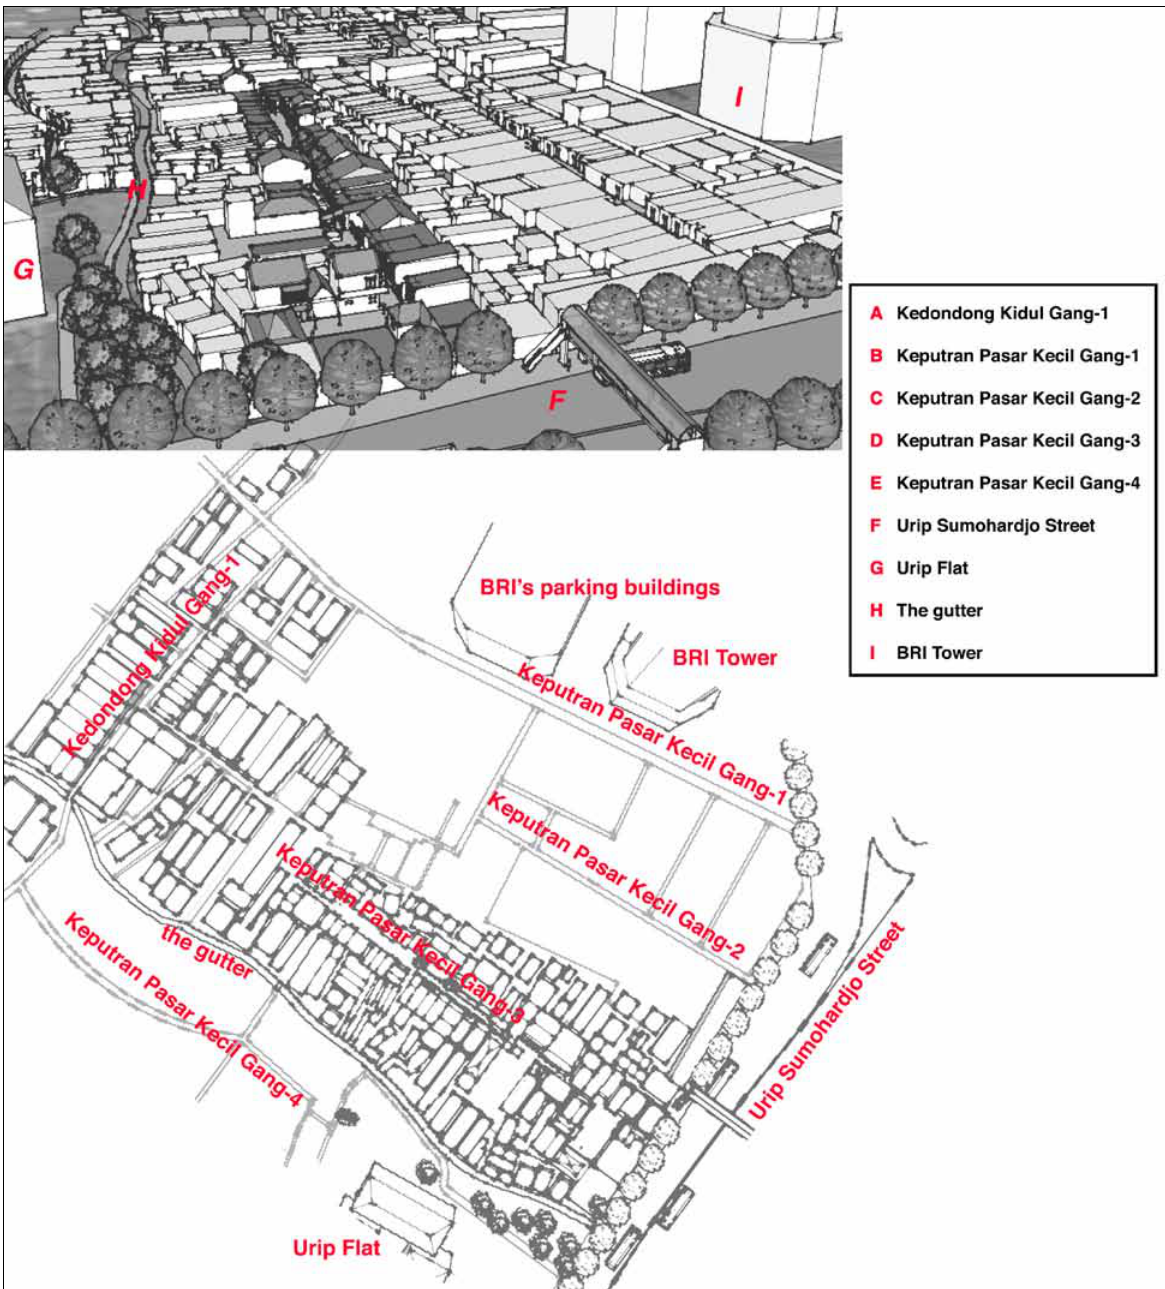
fig. 1. The map of the case